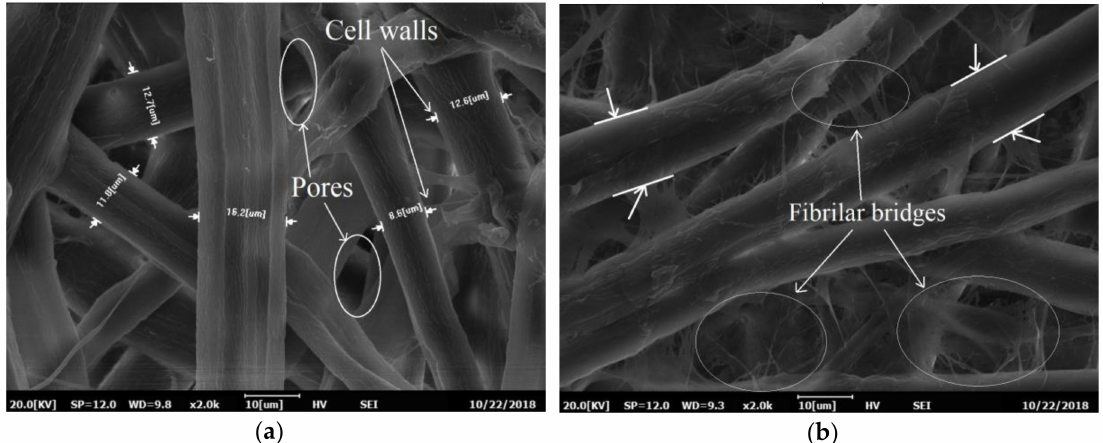
Figure 14. Scanning electron microscope (SEM) images of Kenaf paper at magnification of × 2000 ( a ) unbeaten pulp ( b ) beaten at 12,000